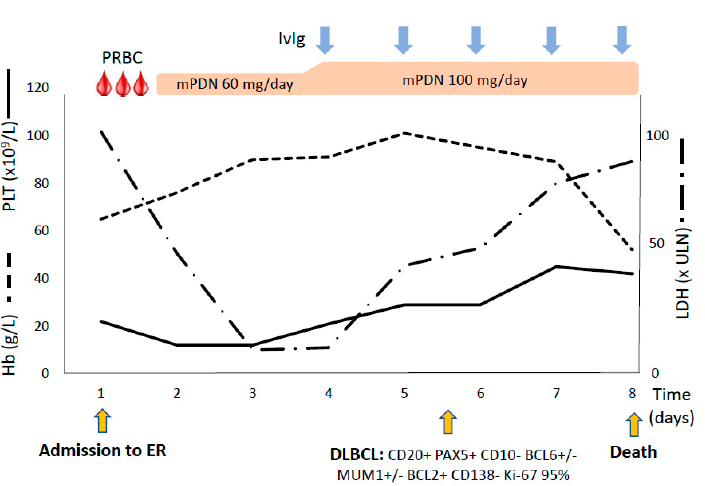
Figure 1. Clinical course of patient #1. Trend of hematologic parameters and therapies administered. Hb, hemoglobin; PLT, platelet count; LDH, lactate dehydrogenase, expressed as times above the upper limit of normal (ULN); PRBC, packed red blood cell units; IvIg, intravenous immunoglobulins; mPDN, methylprednisolone; ER, emergency room; DLBCL, diffuse large B cell lymphoma with its immunophenotype.